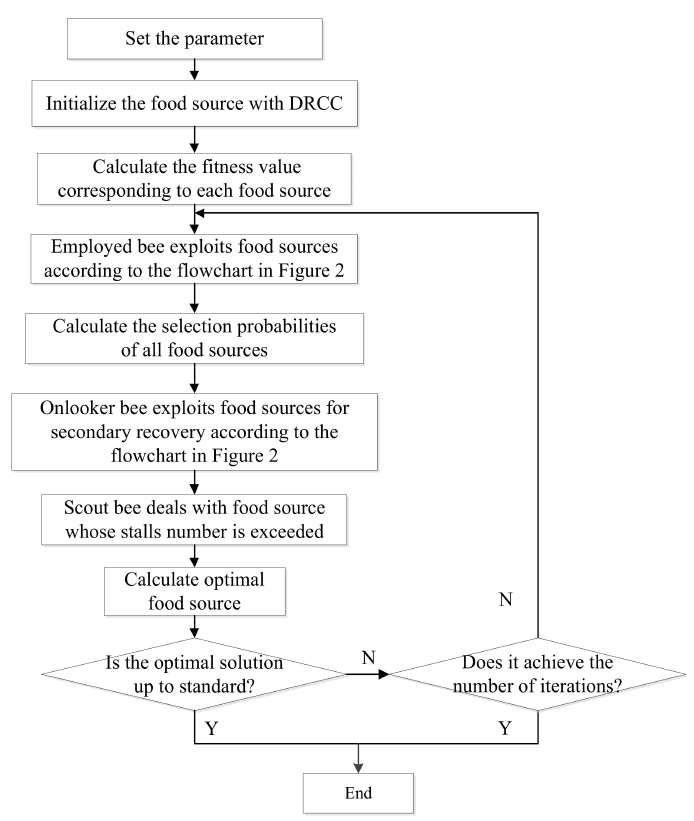
Figure 4. The flowchart of the IABC algorithm.